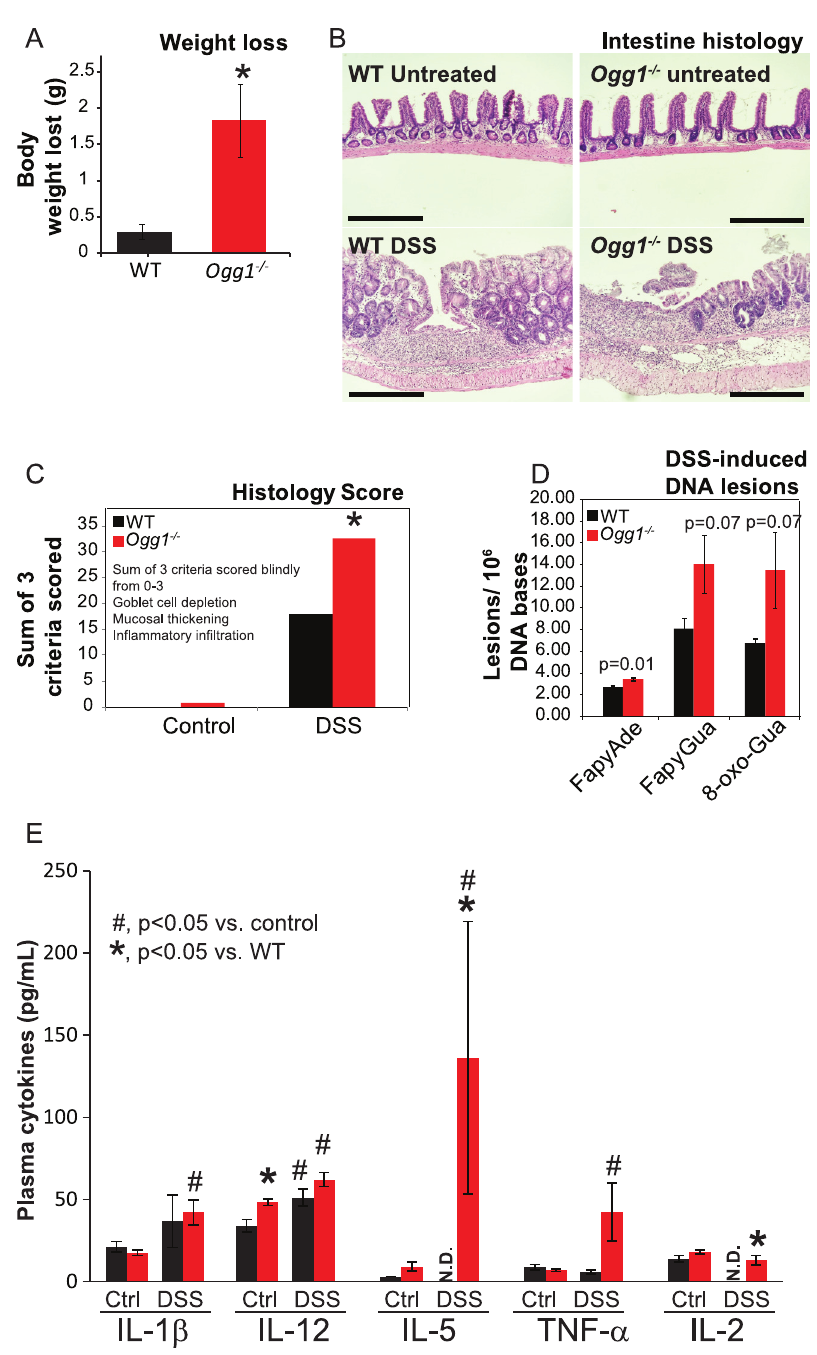
Fig 6. DSS-induced inflammation and colitis in Ogg1 -/- mice. (A) Weight loss was measured after 5 days of oral DSS administration; (B) Intestinal structure was visualized by H&E staining of formalin-fixed paraffin-embedded sections; scale bars represent 220 μ m; (C) Intestine sections were assigned a histological score by blinded scoring of 3 criteria, including goblet cell depletion, mucosal thickening, and inflammatory infiltrate; (D) Oxidative DNA lesions were quantified by GC-MS/MS; (E) Serum levels of inflammatory cytokines were determined by Luminex multiplexed immunoassay.